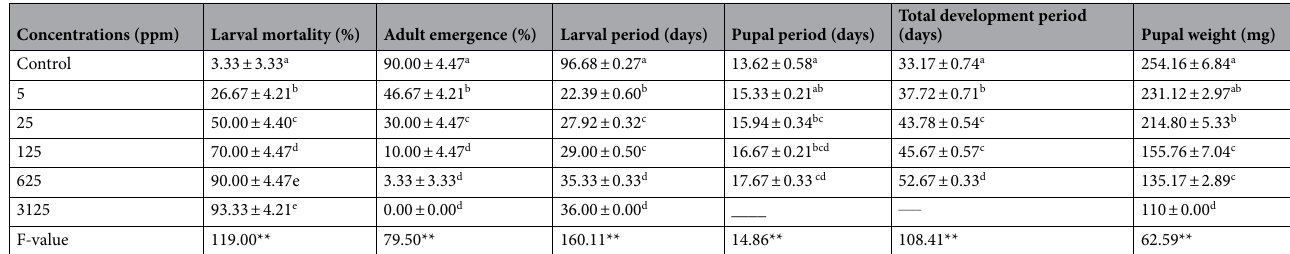
Total development period